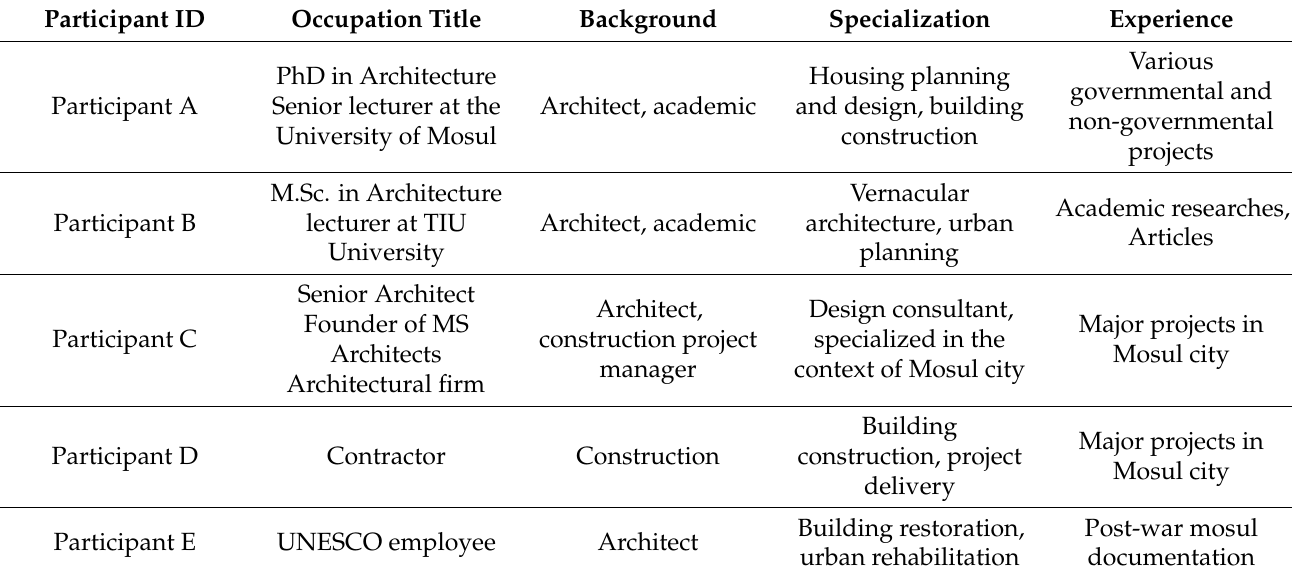
Table 1. Overview of